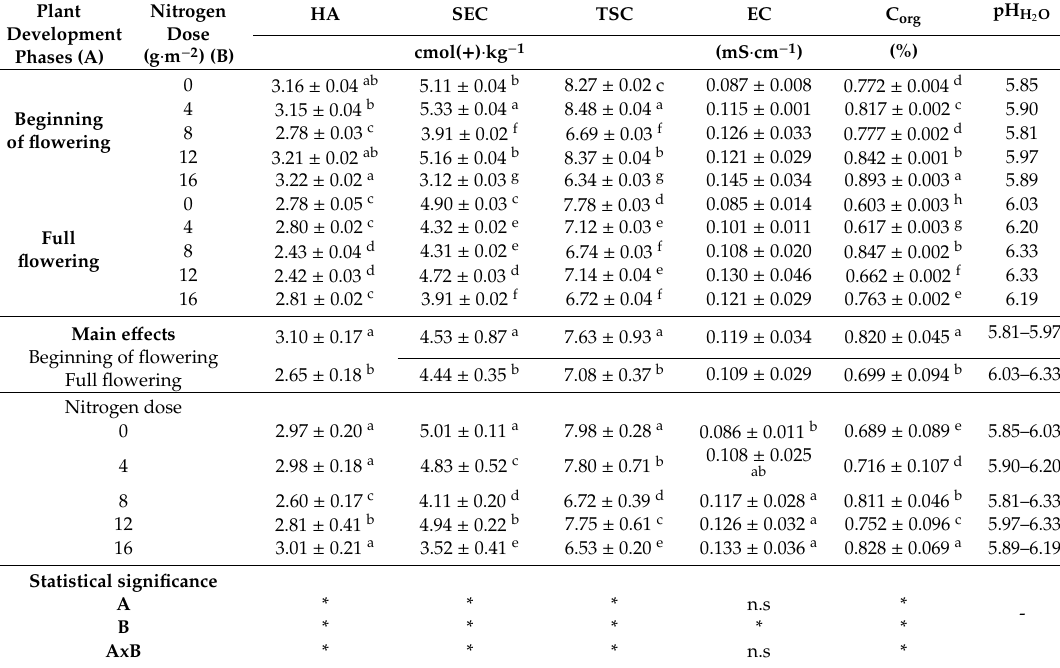
Table 3. Cation exchange properties as well as pH and EC in the soil after the summer savory harvest (mean for 2014–2016) (Note: For an explanation, see Table 1).